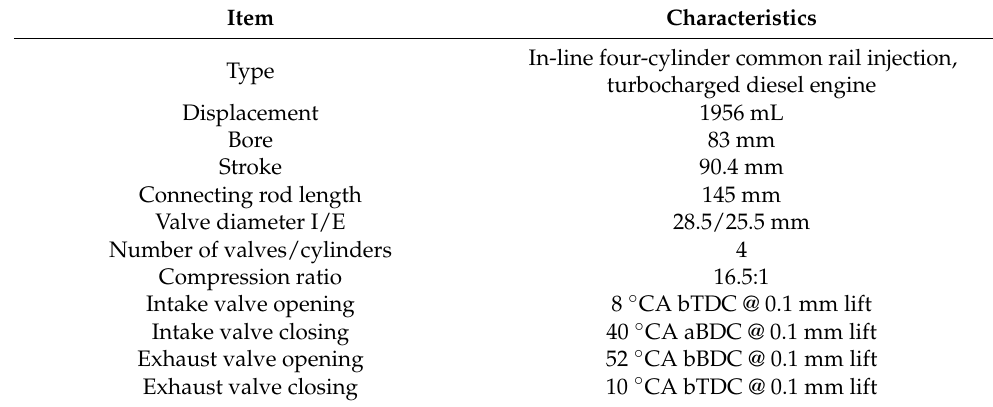
Table 1. Engine specifications of GM A20DTH.